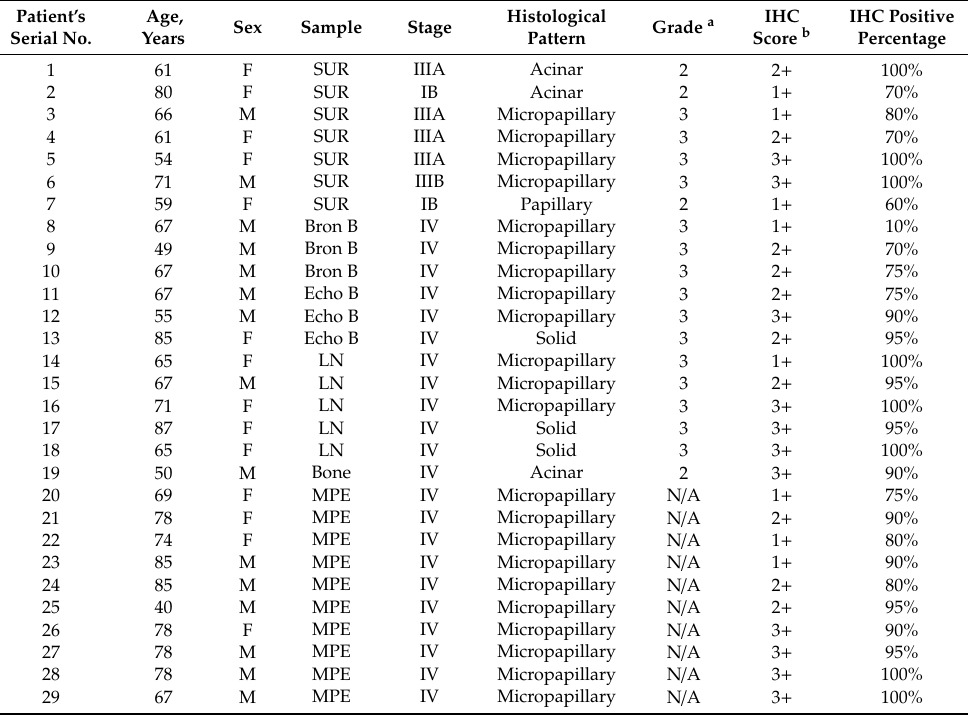
Table 2. Pathological characteristics of patients with lung adenocarcinoma ( n = 29) harboring BRAF V600E